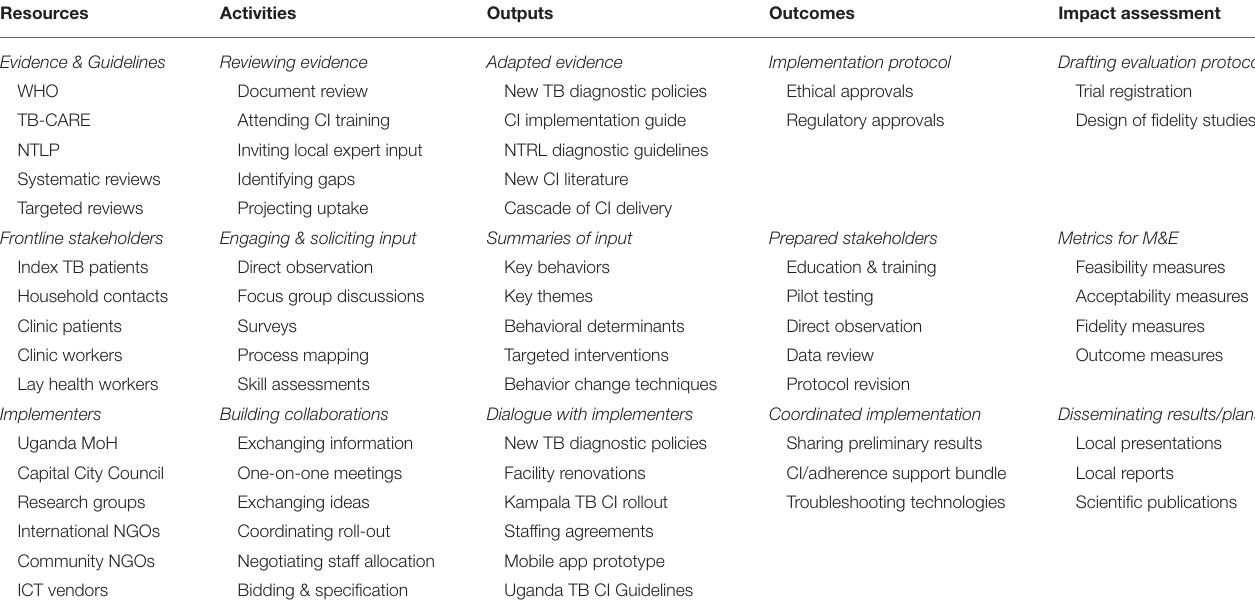
TABLE 4 | Logic model for design of a novel implementation strategy to adapt and deliver household TB contact investigation.